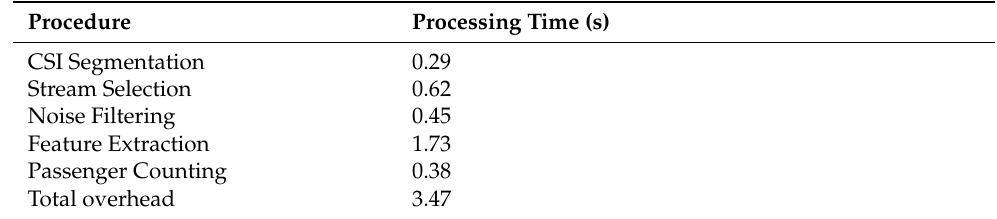
Table 2. System overhead of the main